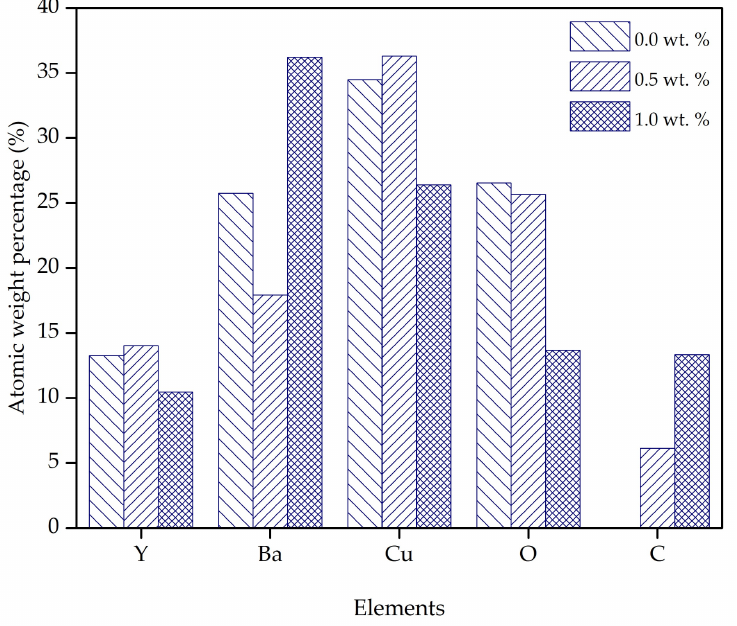
Figure 5. Histogram of average weight percentages of pure Y123 and Y123 added with graphene nanoparticles up to x = 1.0 wt.% from the EDX